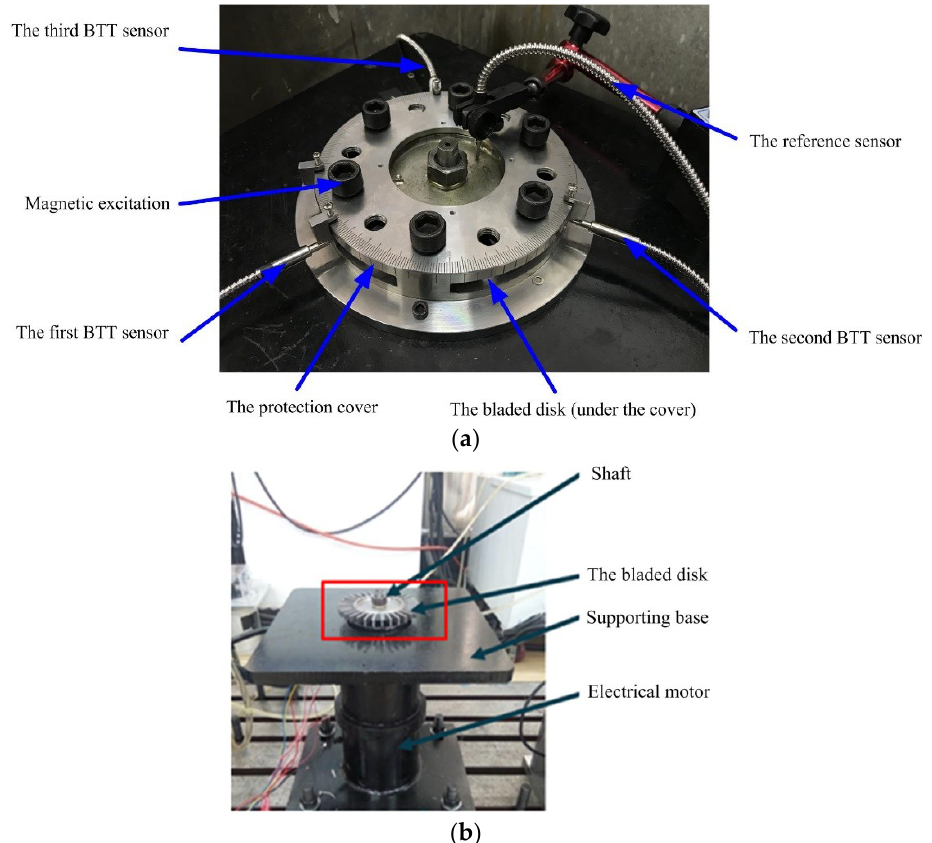
Figure 18. Experimental rig of high-speed rotating blades. ( a ) The whole view; ( b ) Uncovered view. Table 1. Mechanical and geometrical properties of the blade used in the experiment.